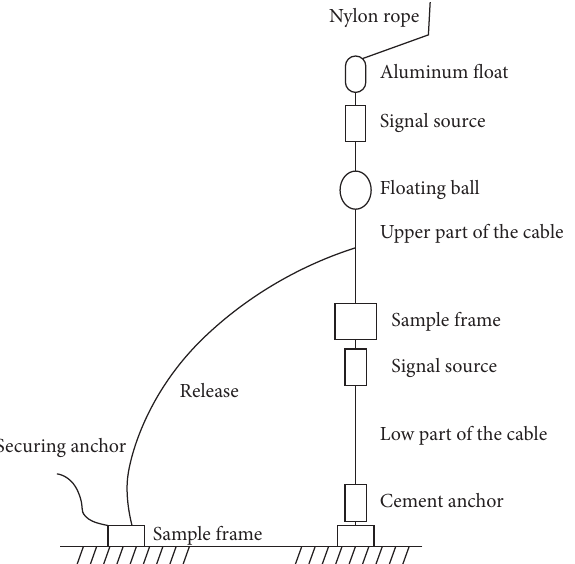
Figure 3: Seated bottom type deep-sea corrosion test device (figure from [5].